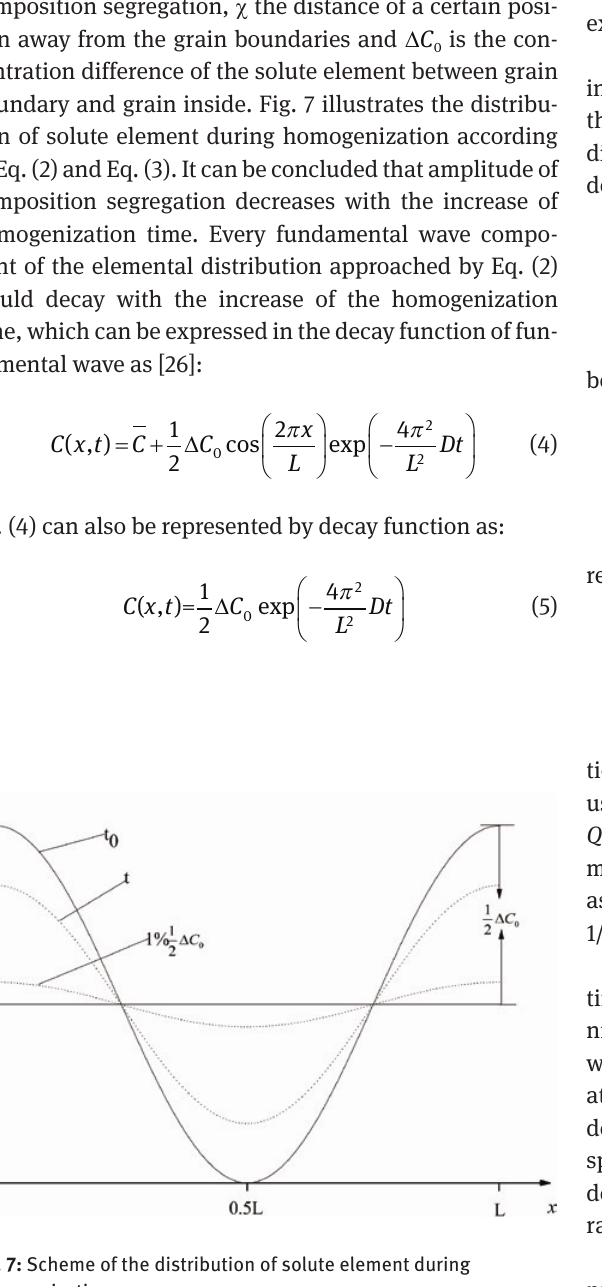
Fig. 7: Scheme of the distribution of solute element during